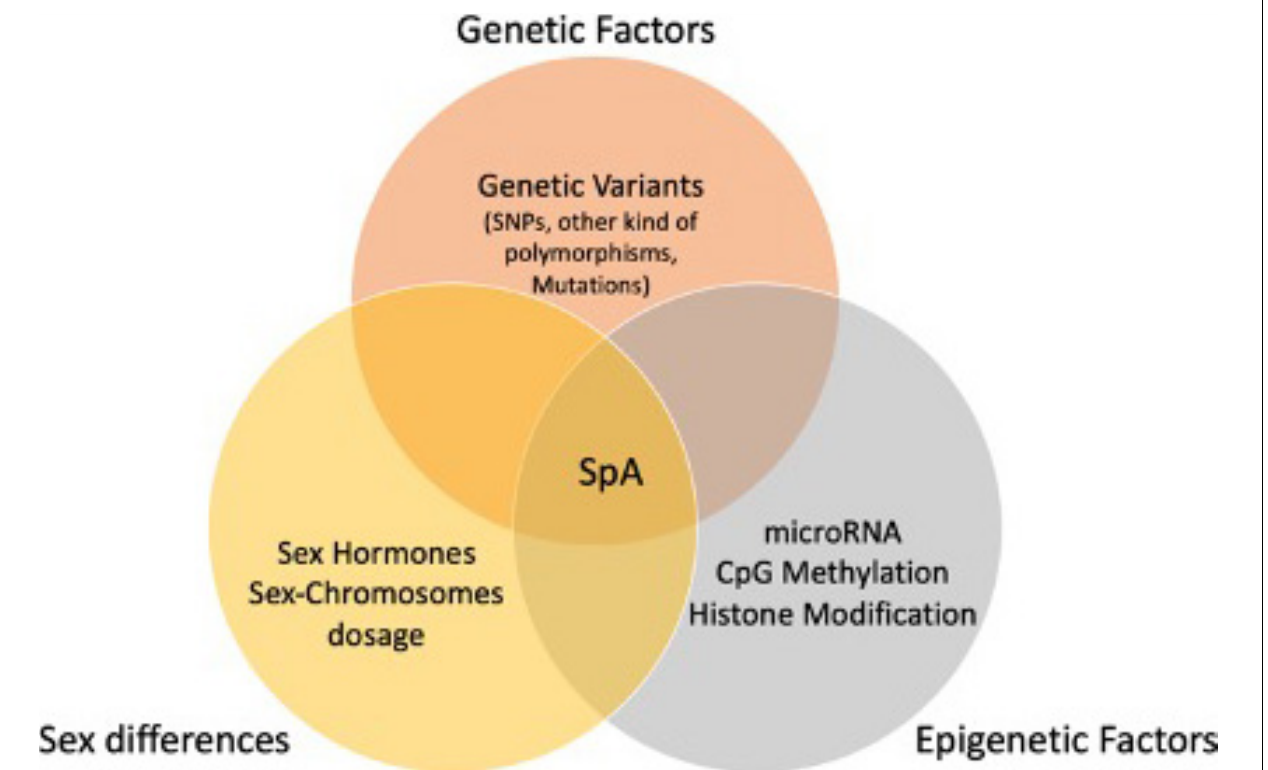
FIGURE 1 | Interaction among genetic and epigenetic factors and sex in Spondyloarthritis